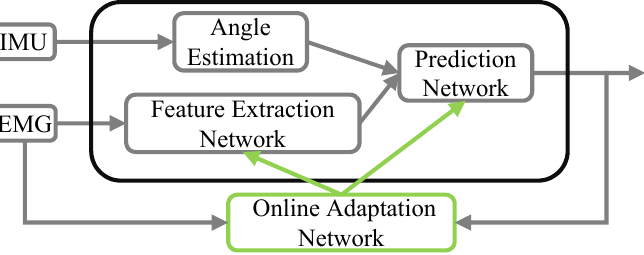
Figure 3. The structure of motion prediction algorithm with adaptation